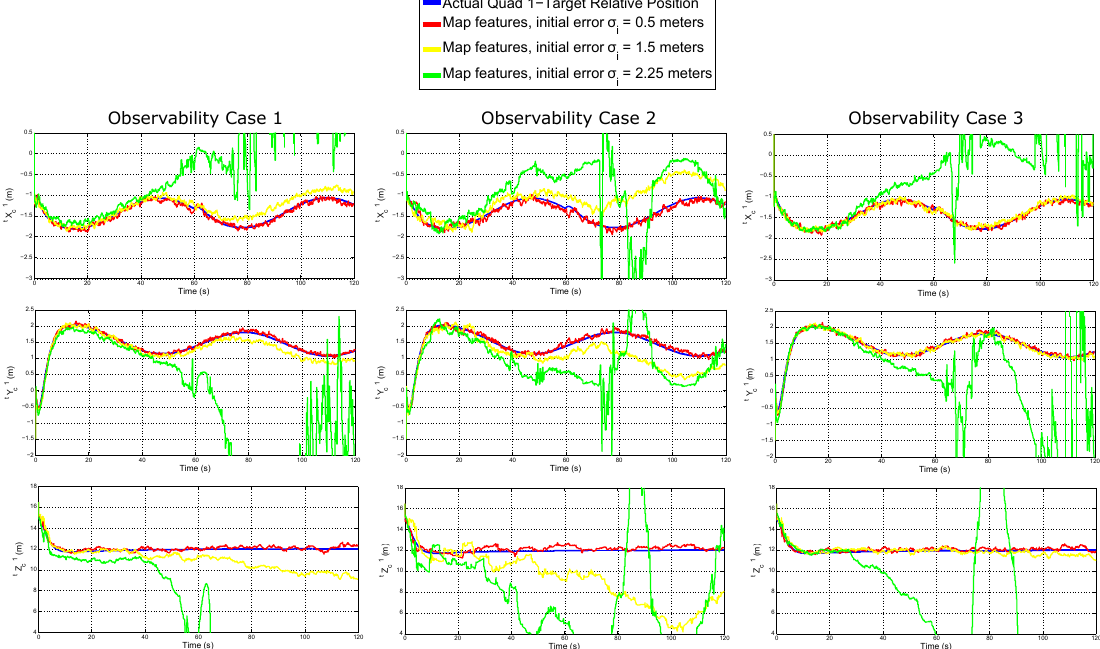
Figure 8. The estimated relative position of the Quad 1 with respect to the target obtained by the Test ( b